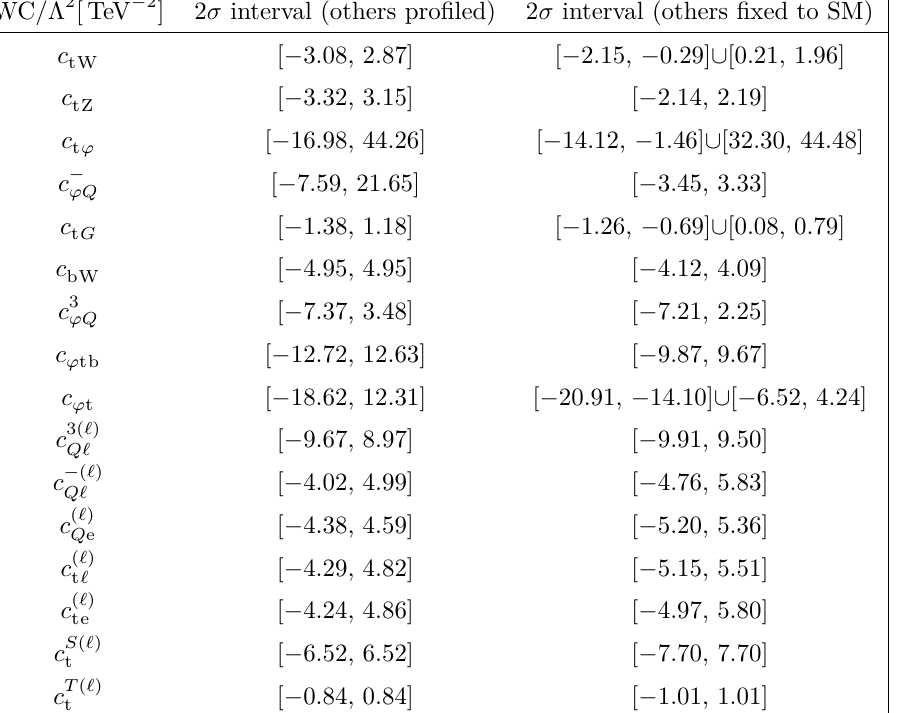
[ − 1.01, 1.01] Table 5 . The 2 σ confidence intervals on the WCs. The intervals are found by scanning over a single WC while either treating the other 15 profiled, or fixing the other 15 to the SM value of